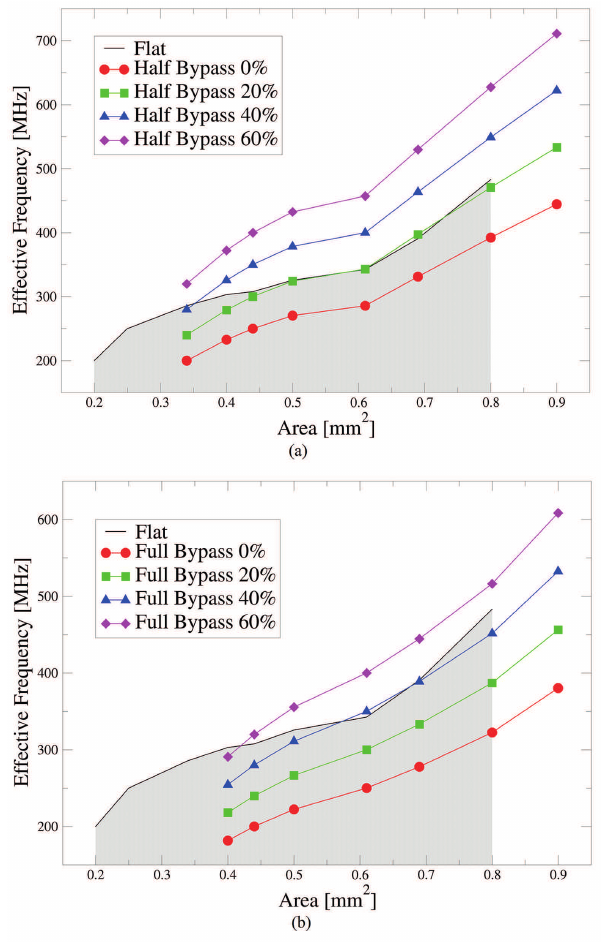
Figure 10. 1024 × 1024 I/Os radix-2 MSSN effective frequency versus area for different frequency gain thanks to bypass exploitation: flat vs. half-bypassed ( a ) and fully-bypassed ( b